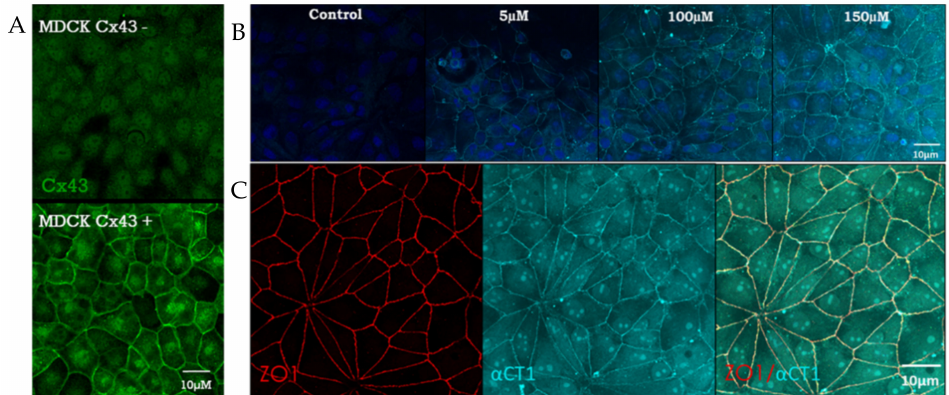
Figure 1. Cx43 CT mimetic peptide, α CT1, colocalizes with ZO1 inside Cx43-deficient MDCK cells. ( A ) Representative confocal images of Cx43-deficient and Cx43-expressing MDCK cells. ( B ) Represen- tative confocal images of the dose-dependent uptake of fluorescent streptavidin-labeled, biotinylated α CT1 (0, 5, 100, 150 µ M) inside Cx43-deficient MDCK cells, fixed at 1 h post-incubation of peptide. ( C ) Representative confocal images of ZO1 + α CT1, combined into a merged image to highlight colocalization